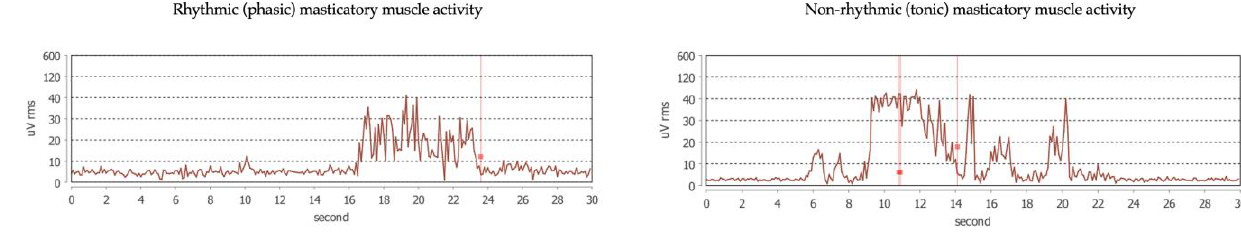
Figure 2. Example traces of different bruxism activities.